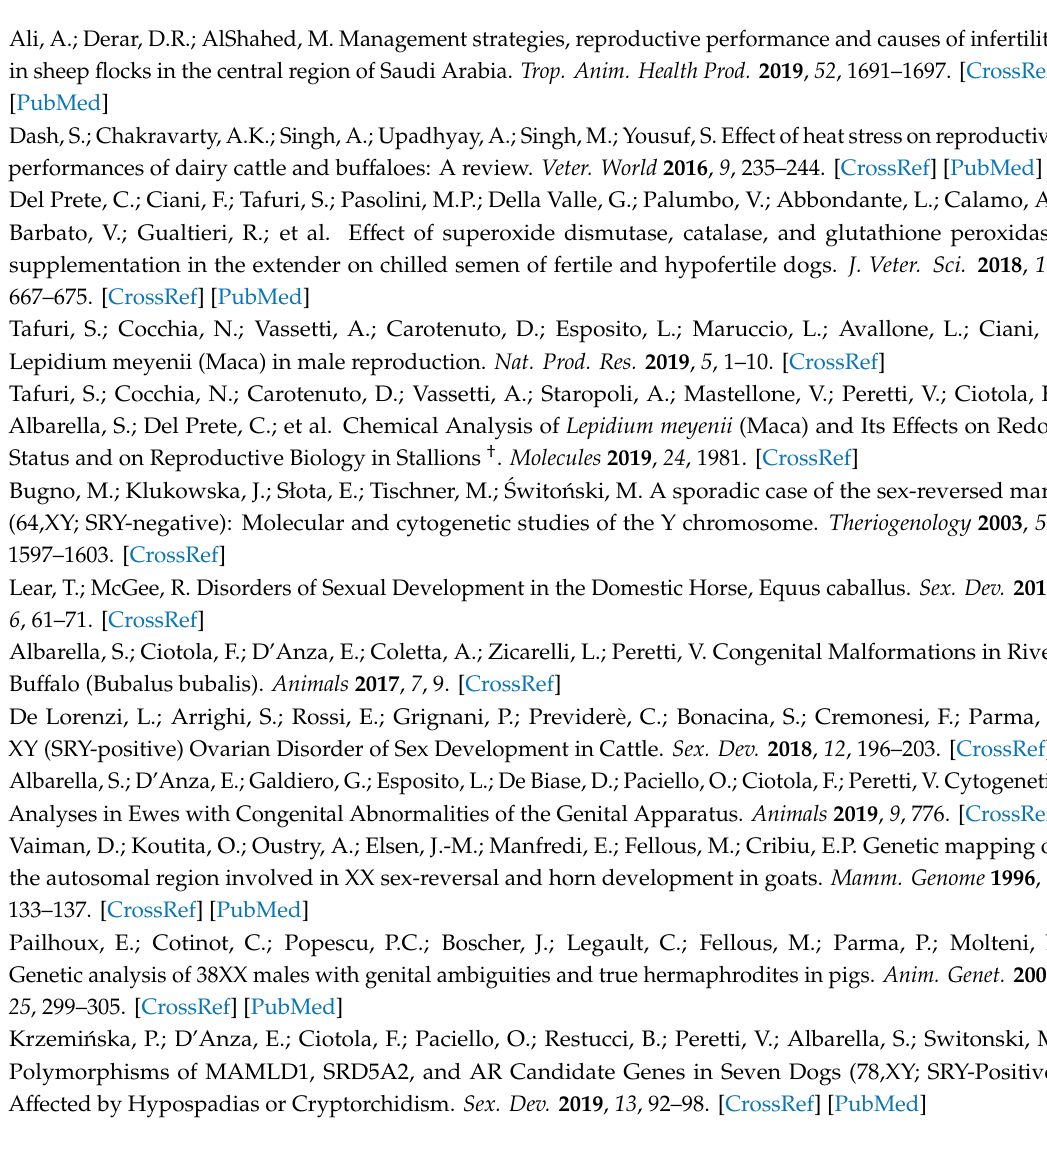
s1, Table S1: Primer sequences, annealing temperatures and product lengths of SRY, ZF9 and RSPO1 gene region